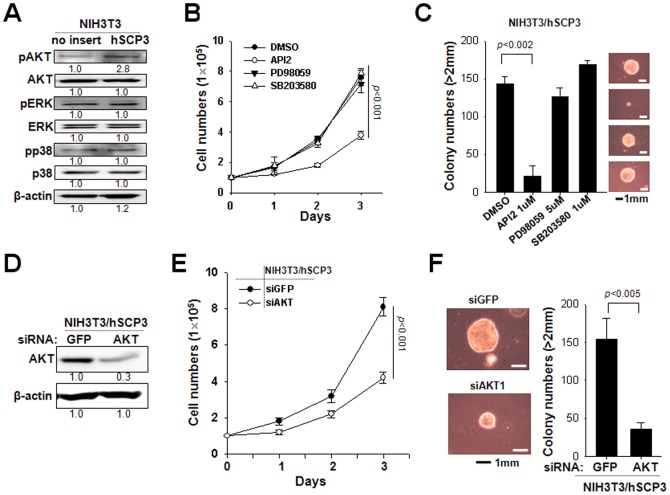
hSCP3 increases tumorigenesis through AKT pathway.(A) Western blot analysis of levels of pAKT, pERK, and pp38 in NIH3T3 cells ectopically expressing hSCP3 or no insert. Numbers below western blots refer to the relative values of the intensity normalized to no insert control. (B) In vitro growth curves of NIH3T3/hSCP3 cells treated with DMSO or API2 (Akt inhibitor), PD98059 (Erk inhibitor), or SB203580 (p38 inhibitor). (C) Soft agar colony-forming capacity of NIH3T3/hSPC3 cells in the presence of API2, PD98059, or SB203580; (C, Right) Representative images of average colony size in each group; (C, Left) bar graph showing the number of colonies with diameters greater than 2 mm in soft agar (scale bar: 1 mm). (D) Western blot analysis of levels of pAKT in NIH3T3/hSCP3 cells transfected with a siRNA targeting GFP or AKT (siGFP or siAKT) to confirm the reduction of AKT protein level. Numbers below western blots refer to the relative values of the intensity normalized to no insert control. (E) In vitro growth curves of NIH3T3/hSCP3 cells transfected with siGFP or siAKT. (F) Soft agar colony-forming capacity of NIH3T3/hSPC3 cells treated with siGFP or siAKT; (Left) Representative images of average colony size in each group; (Right) Bar graph representing the number of colonies with diameters greater than 2 mm in soft agar (scale bar: 1 mm). Error bars represent the mean ± SD.